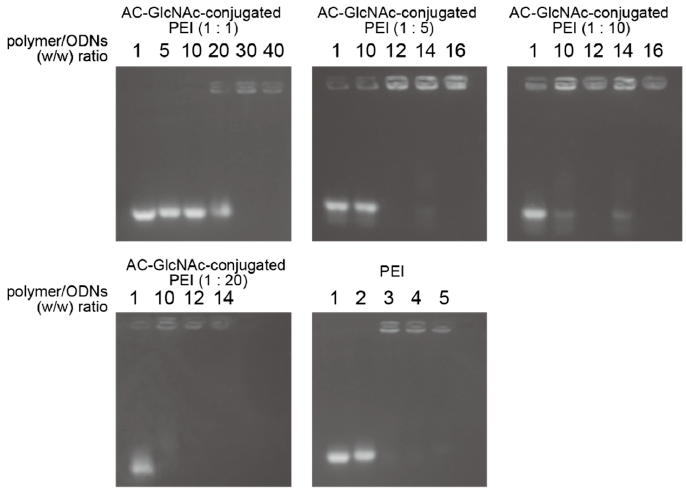
Figure 3. Gel retardation assay for complexes of AC-GlcNAc-conjugated polyethyleneimine (PEI) and nuclear factor (NF)- κ B decoy oligonucleotides by agarose gel electrophoresis.